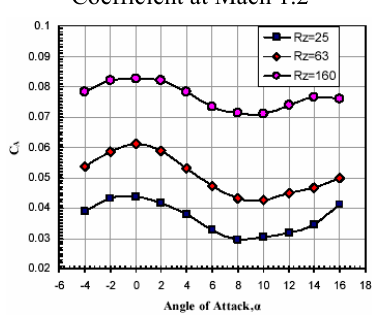
Fig. 15 Comparison of normal force Coefficient at Mach 1.2